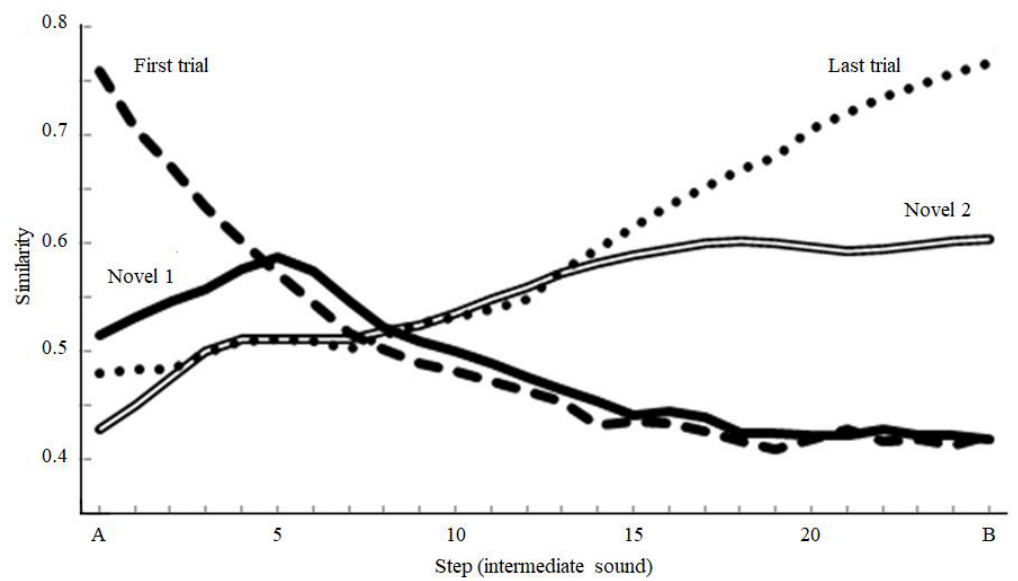
Figure 4. Transition of the similarity between the playback sounds and each vocal pattern through a session in Experiment 3 (corresponding to Figures 2 and 3). Because the playback sounds were shifting from the contour-A to contour-B, similarity between vocal pattern A (produced at the 1 st trial) and playback sound was going down as the trial was going. Likewise, similarity between vocal pattern B (produced at the last trial) and playback sound was going up as trial was going. However, novel vocal pattern 1 was more similar to intermediate sounds than A and B. Values of novel vocal repertoire 1 and 2 were average of each